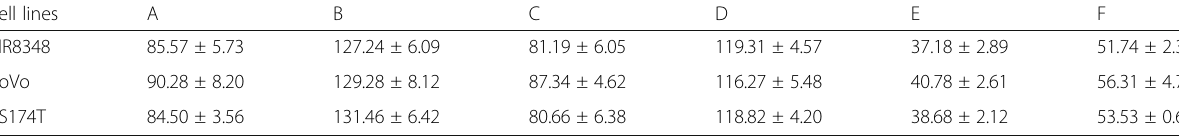
Table 1 Half maximal inhibition concentration (IC50) values of triphalas and chebulic ellagitannins cell